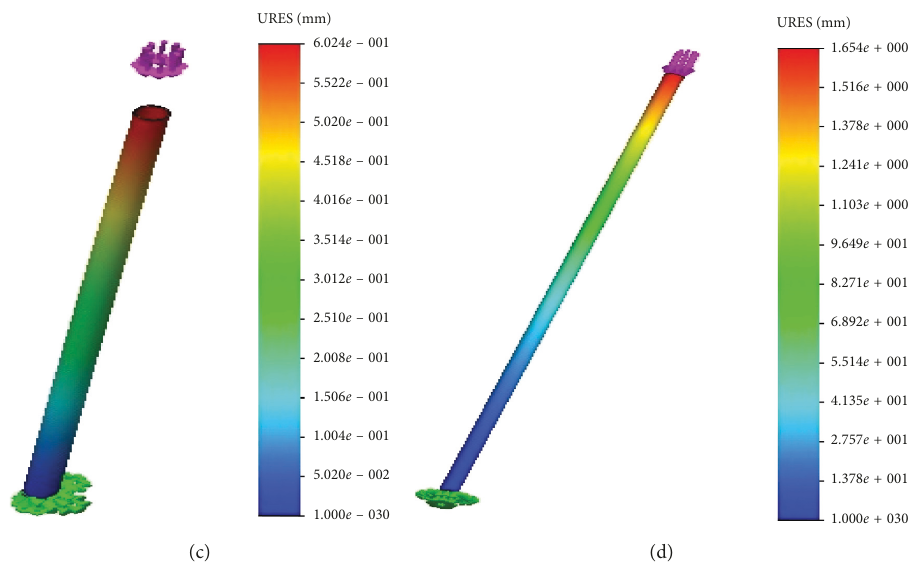
Figure 9: Displacement according to Zry-4 tube lengths: (a) 300mm, (b) 400mm, (c) 500mm, and (d) 600mm.